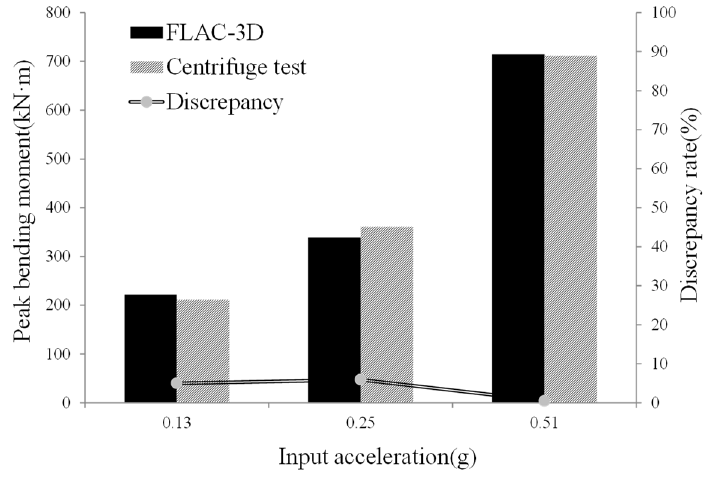
Figure 12. Measured and calculated maximum values of bending moments for various input amplitudes for Nisqually earthquake (Model 2, Nisqually earthquake).